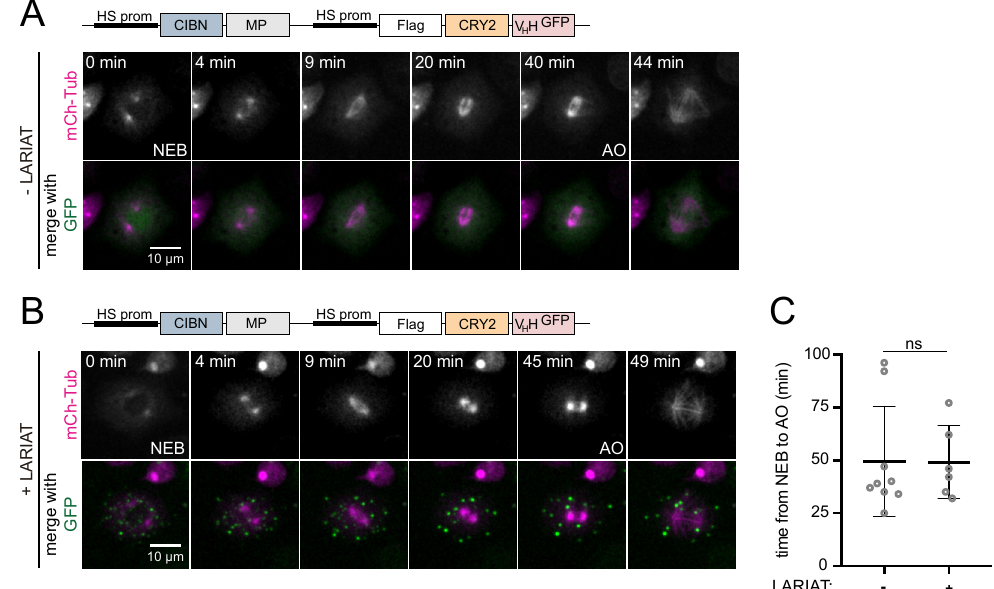
Figure 4. LARIAT clusters do not affect bipolar spindle assembly and mitotic progression. Clustering effect on mitotic progression was analyzed through live-imaging of Drosophila S2 cells expressing GFP, mCherry- α -Tubulin ( A ) alone, and co-transfected with CIBN-MP and Flag-CRY2-V H H ( B ). The 488 nm laser used to image GFP triggered clustering since the prophase stage. LARIAT expression was confirmed by measuring GFP coefficient of variation in the first three frames of each movie. ( C ) Graph shows average mitotic timing ± SD. Mitotic timing is defined as the time it takes for a cell to progress from nuclear envelope breakdown (NEB) to anaphase onset (AO). Not significant (ns) p = 0.2149 (Mann-Whitney test).